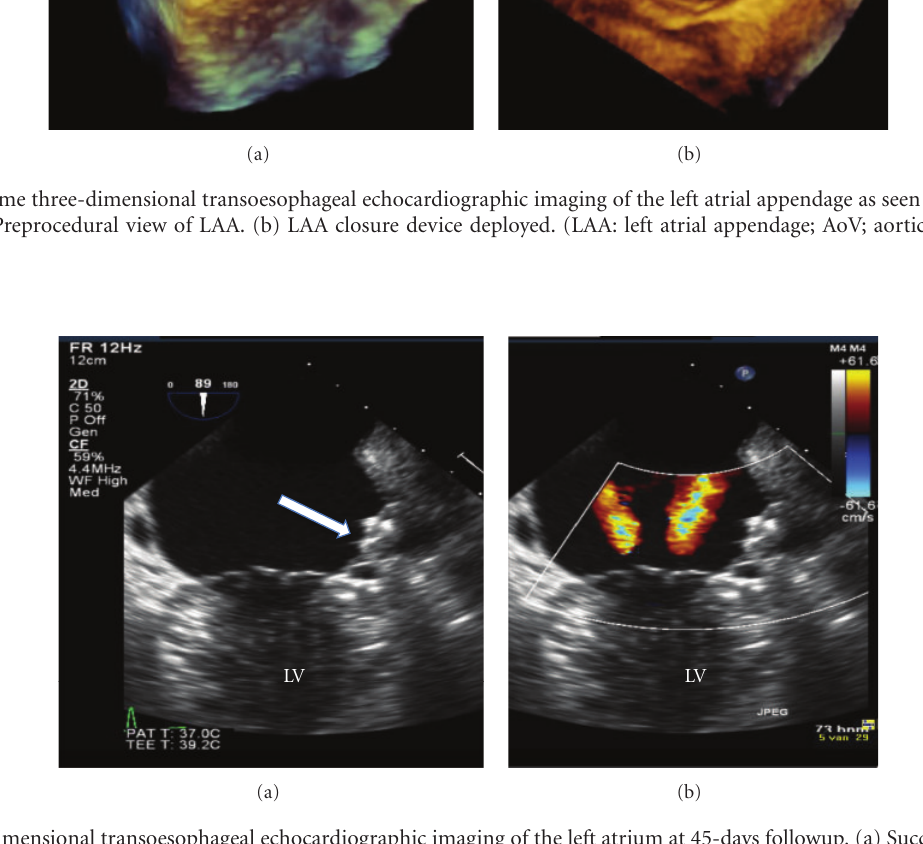
Figure 2: Two-dimensional transoesophageal echocardiographic imaging of the left atrium at 45-days followup. (a) Successful occlusion of the LAA without thrombus formation on the atrial surface of the device despite the limited use of anticoagulation therapy (aspirin only). (b) No residual flow around the device. LV: left ventricle